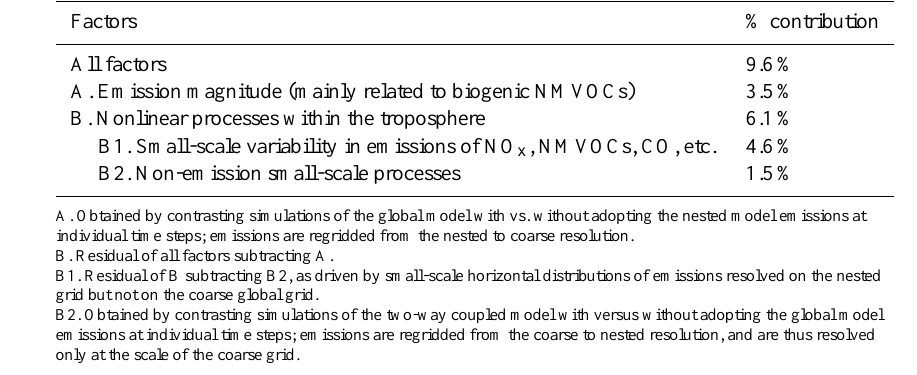
Table 3. Percentage contributions of individual factors to the difference in January 2009 tropospheric CO between the two-way coupled model and the global model, after a 6-month spin-up from July 2008 with consistent initial conditions of chemicals.